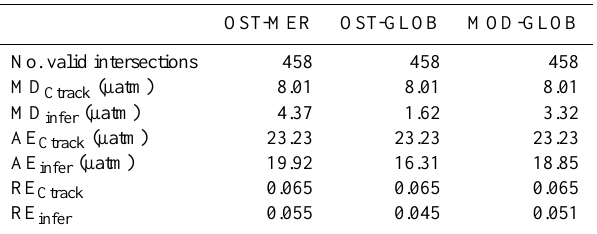
Table 5. Mean difference, absolute error and relative error of p CO 2 values obtained from CarbonTracker and p CO 2 values inferred at super resolution with respect to values of p CO 2 measurements during the QUIMA2005/QUIMA2006/QUIMA2008 cruises in the Benguela region at the same